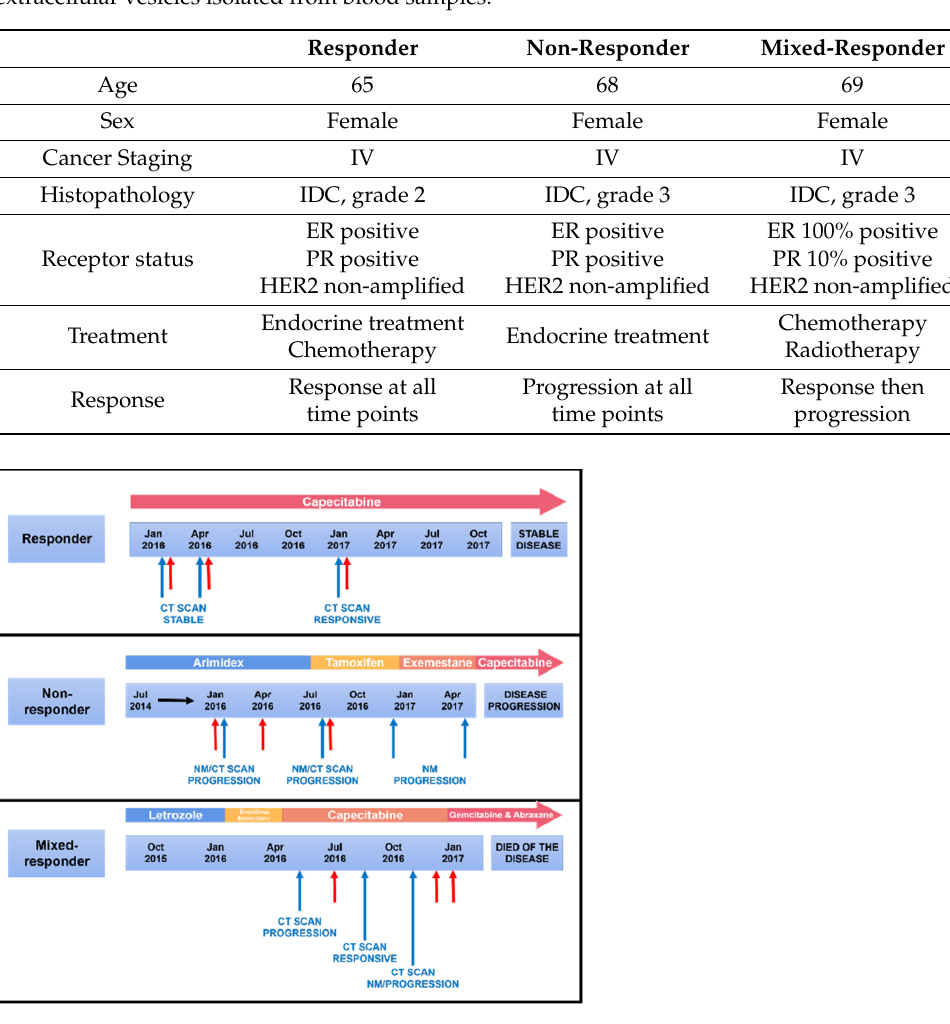
Figure 1. Treatment regimes, time of blood draws and response patterns. Blue and red arrows indi- cate time of scans and blood collection, respectively. *Computerised tomography (CT), nuclear med- icine